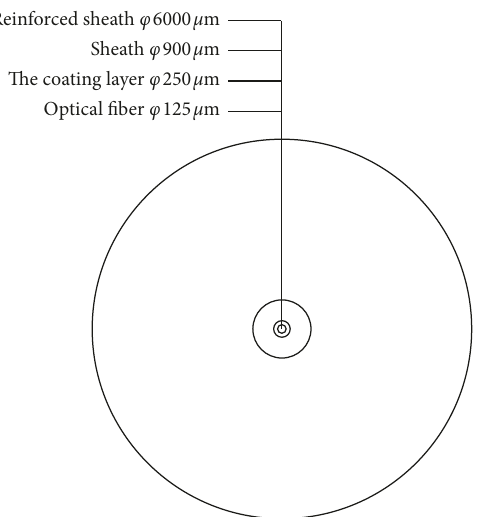
Figure 3: Structures of the optical fiber.